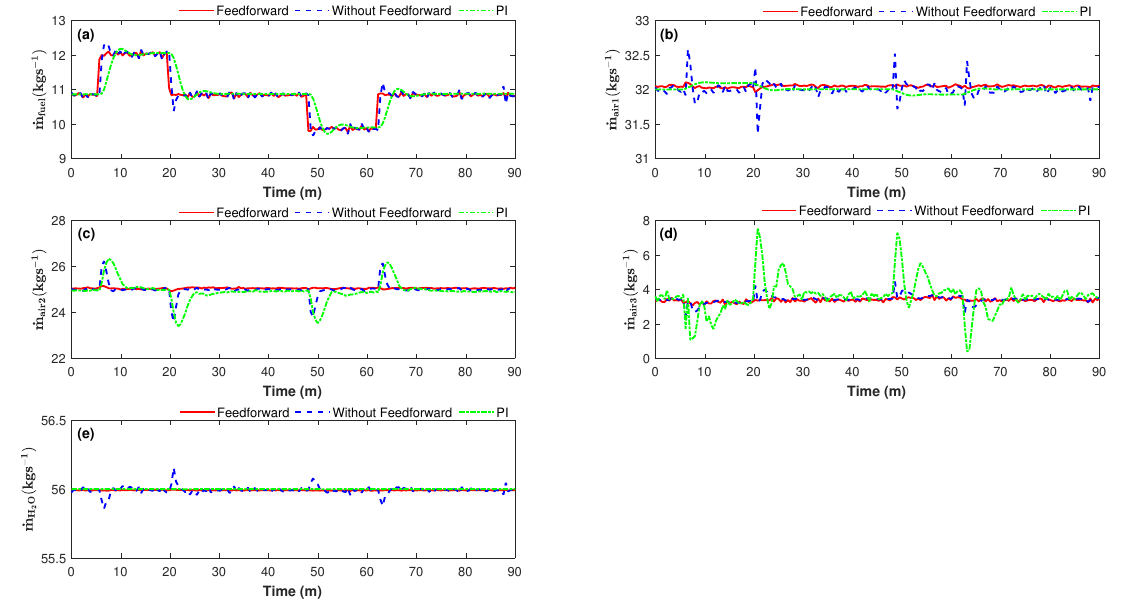
Figure 10. Control variable responses for the fuel mass flow ( a ); primary air flow ( b ); secondary air flow ( c ); tertiary air flow ( d ); and feed water flow rate ( e ). Illustrating feedforward and without feedforward MPC (model predictive control), with reference PI